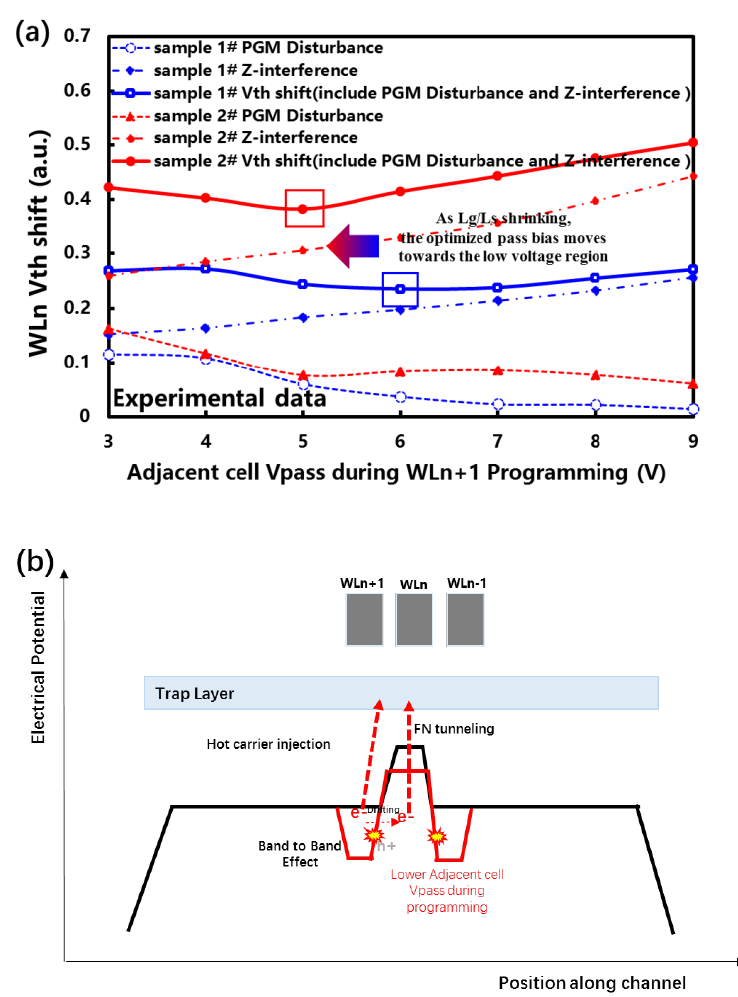
Figure 6. ( a ) Program disturbance and z-interference inducing Vth shift with different levels of adjacent cell Vpass (the blue lines indicate thicker Lg/Ls device electrical properties; the red lines indicate thinner Lg/Ls device electrical properties). ( b ) Explanatory diagram of the proposal scheme’s impact on the program